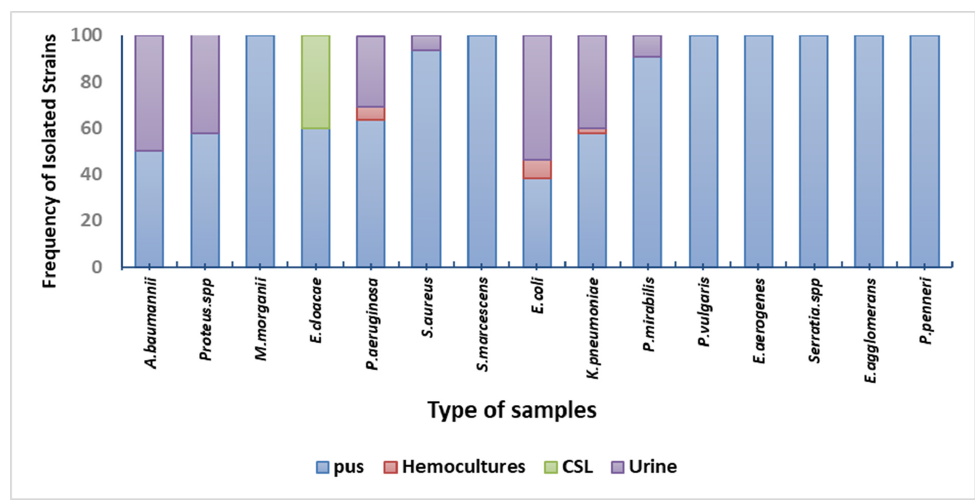
Figure 2. Distribution of clinical bacterial isolates according to specimens.